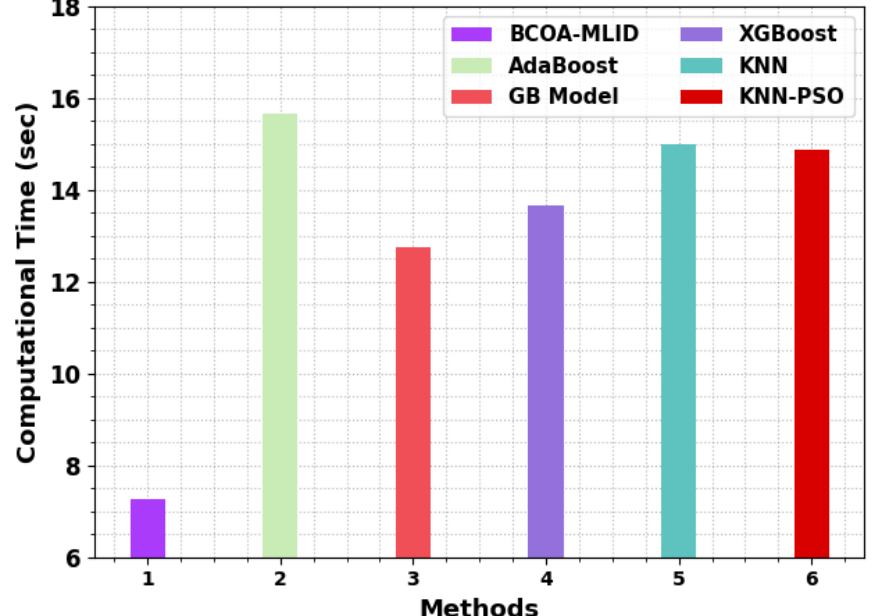
Figure 9. CT outcome of the BCOA-MLID approach with recent systems.